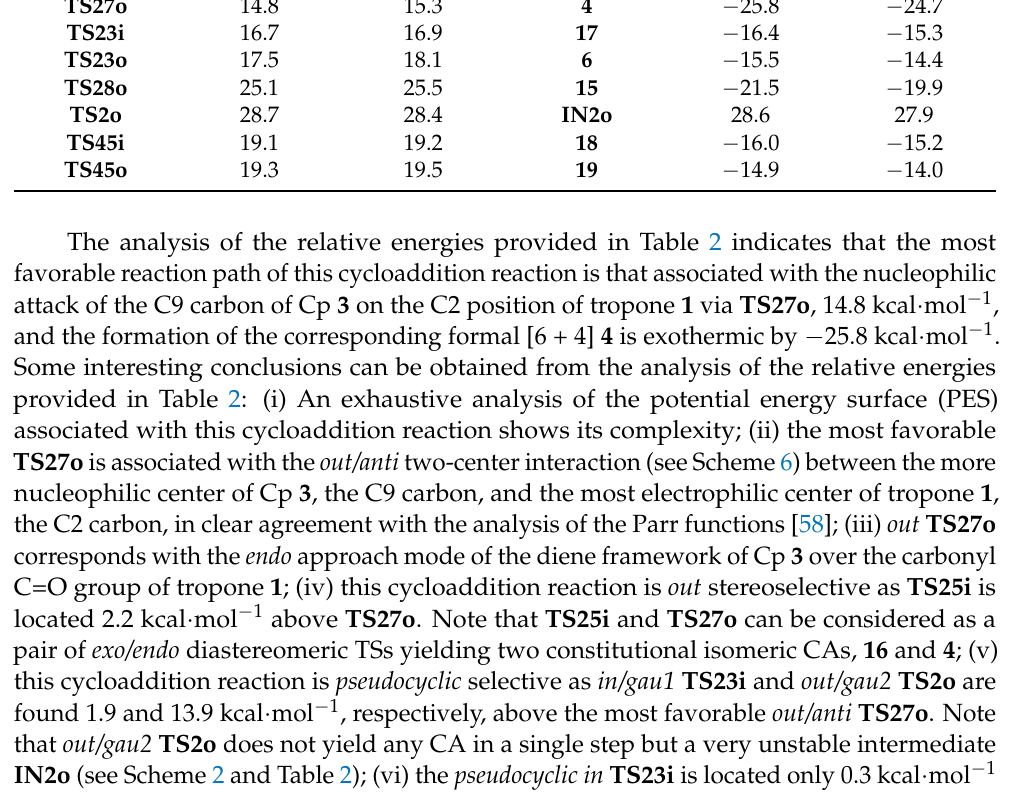
Table 2. ω B97X-D/6-311G (d,p) relative electronic energies, in kcal mol − 1 , in gas phase, and benzene, of the stationary points involved in the cycloaddition reaction of tropone 1 with Cp 3 .